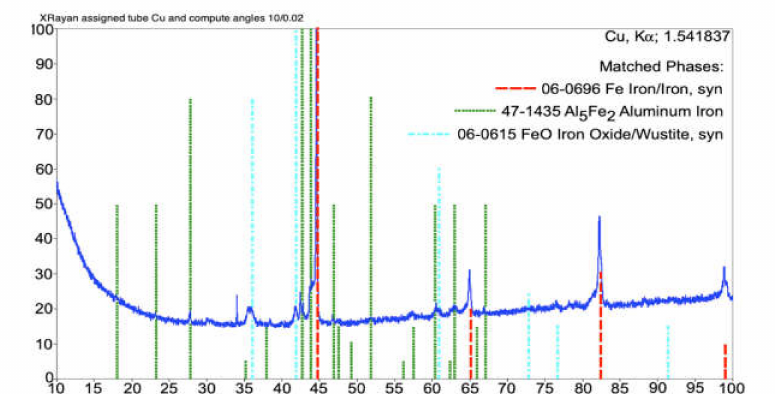
Figure 9. XRD diffraction pattern of the arc-sprayed Fe-Al coating after 700 ◦ C annealing.